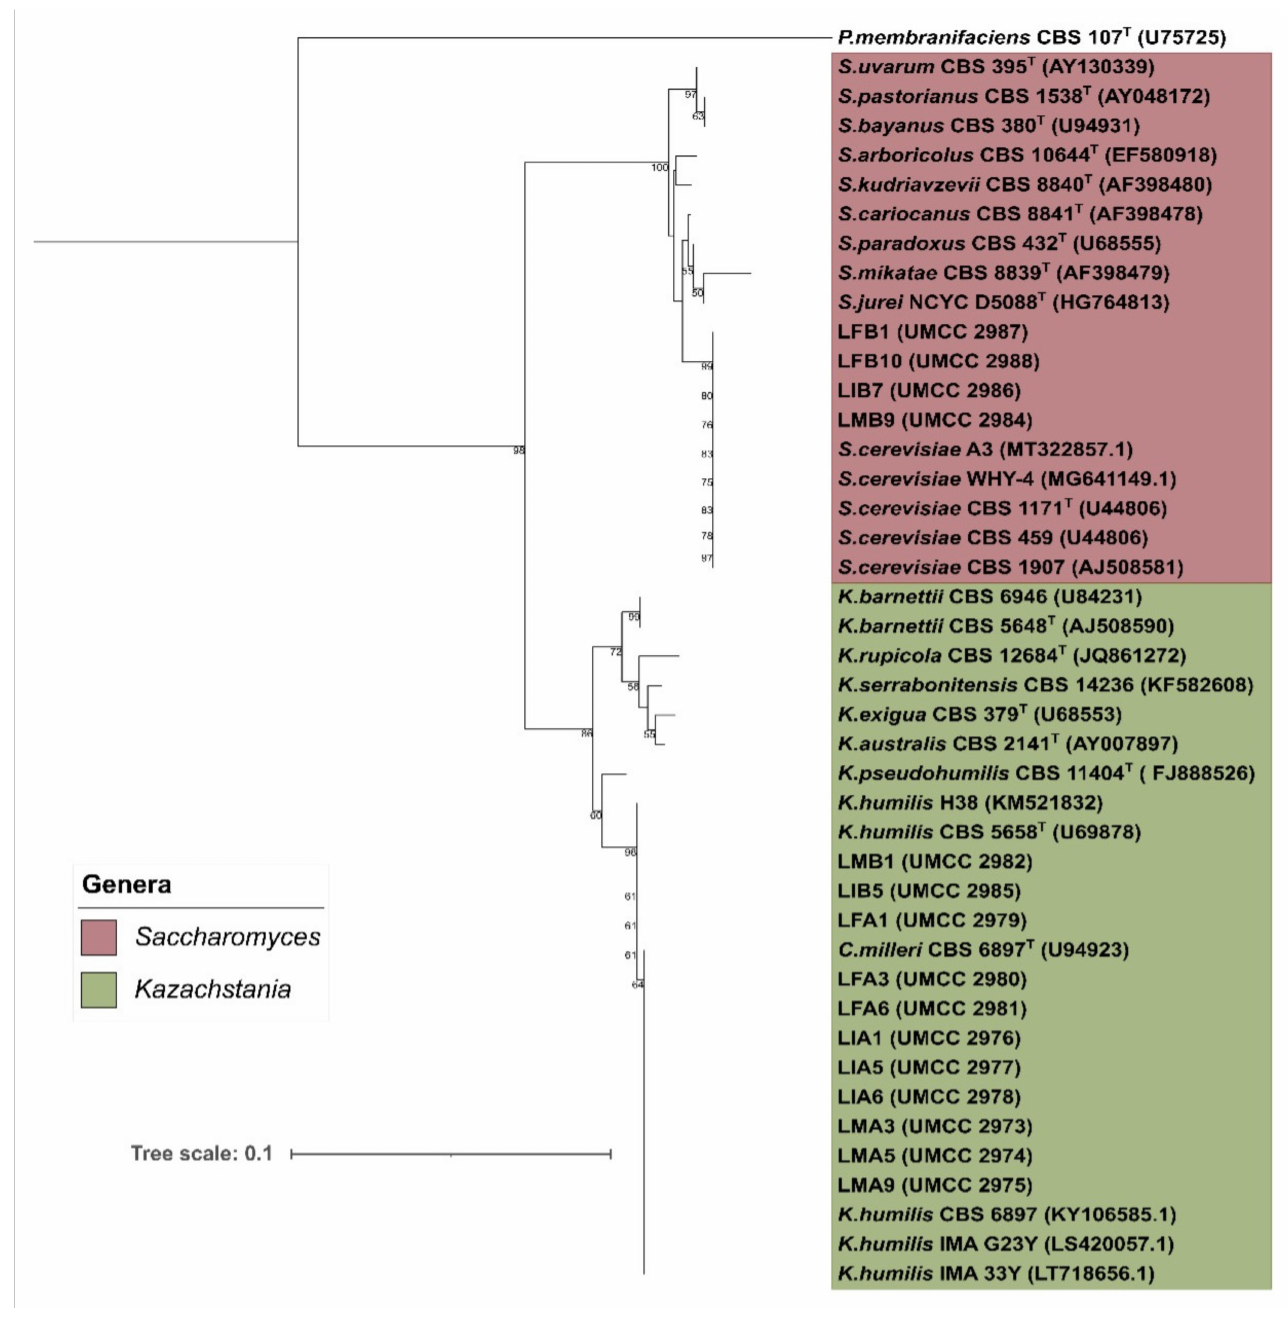
Figure 3. Neighbor-joining phylogenetic tree representing the phylogenetic distances of isolates from sourdough MA and MB and the strain types of identified yeasts species. The tree was made using Tamura-Nei model, and a discrete Gamma distribution was used to model evolutionary rate differences among sites. Node numbers indicate bootstrap values obtained using 1000